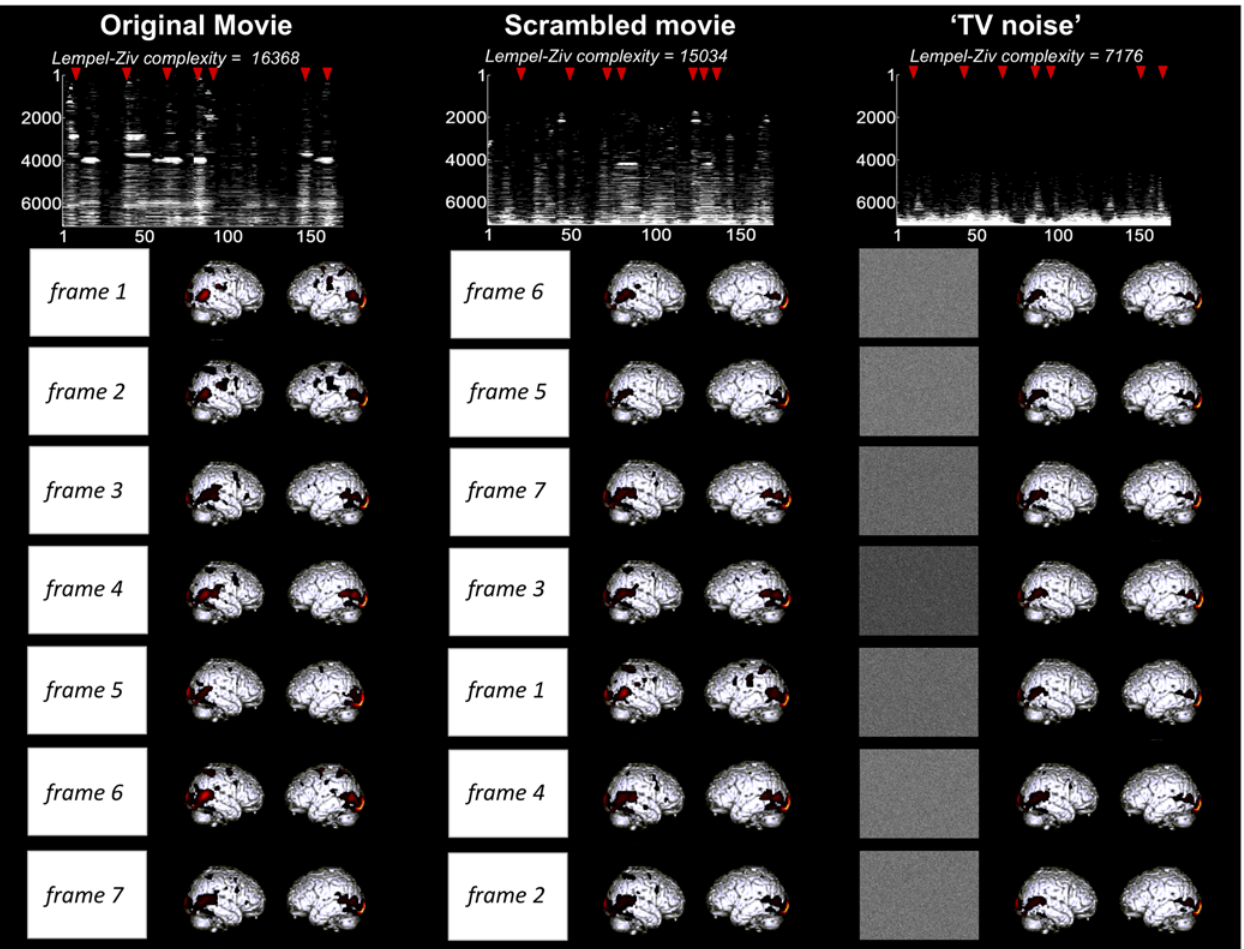
Fig 5. Lempel-Ziv complexity of brain activity correlates with stimulus set meaningfulness — comparison to the sequence mean. Figure displays differentiated brain activity patterns for movie, scrambled movie, and ‘ TV noise ’ stimulus sequences for the representative subject also used in Figs 2 – 3. Brain activity patterns over time are highly differentiated in the movie condition, intermediate in the scrambled movie condition, and very low in the ‘ TV noise ’ condition. Brain maps are here expressed in terms of significant changes in activity as compared to the within-session mean (F-test) thresholded at whole brain FWE corrected p < 0.05 for each frame. Top panel displays binarized spatio-temporal activation/deactivation matrices obtained for the 3 conditions after statistical thresholding was applied — where a value of 1 was assigned to above threshold voxels for each scan, and a value of zero to voxels below threshold. For display purposes, binarized activation matrices are displayed only for the voxels that show at least once a significant activation in the movie (data dimension reduction from 94000 to ~900 voxels). Lempel-Ziv complexity was computed at the whole brain activation matrix encompassing 94000 voxels in each